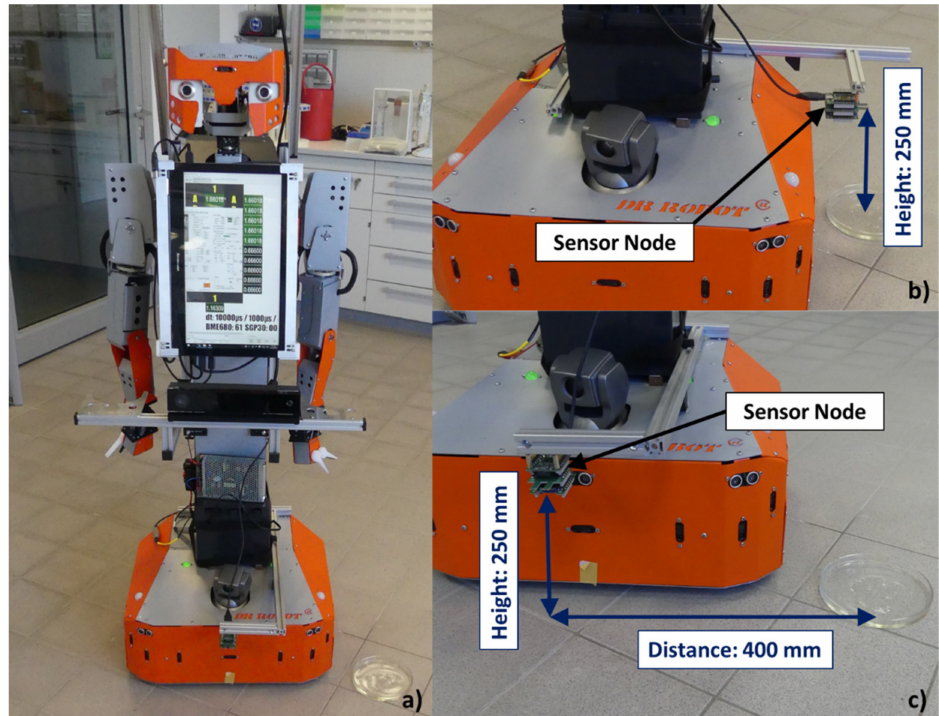
Figure 17. ( a ) H20 robot and the petri dish in a celisca laboratory; ( b ) Experiment setting for the side-mounted sensor node; ( c ) Experiment setting for the front-mounted sensor